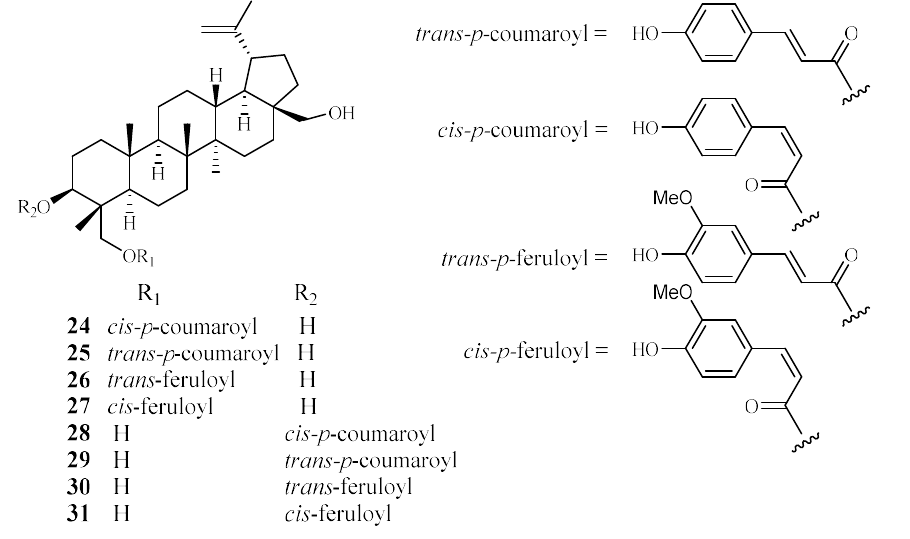
Figure 7. Compounds from a Buxaceae plant.